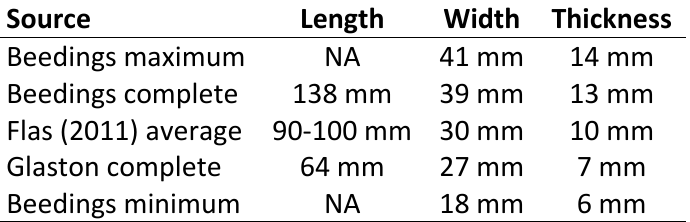
Table 1. Artefacts and data used to define the maximum (top two lines) and minimum (bottom two lines) blade- point criteria. Abbreviations: NA –“Not